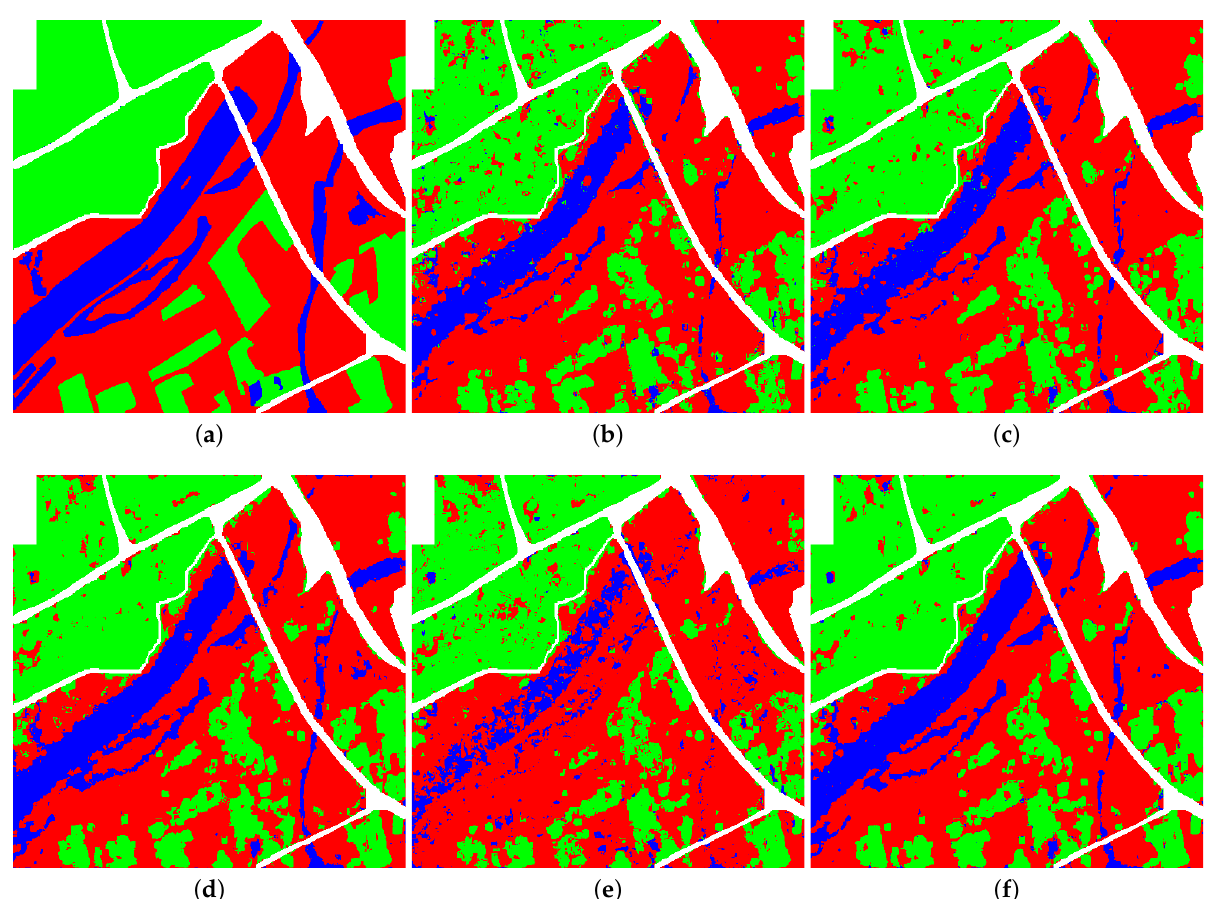
Figure 13. Classification results of five classifiers on the ground-truth map of Xian area: ( a ) Ground-truth map, ( b ) SVM_PP, ( c ) SVM_LP, ( d ) ANN_Opt, ( e ) ANN_MIM, and ( f )